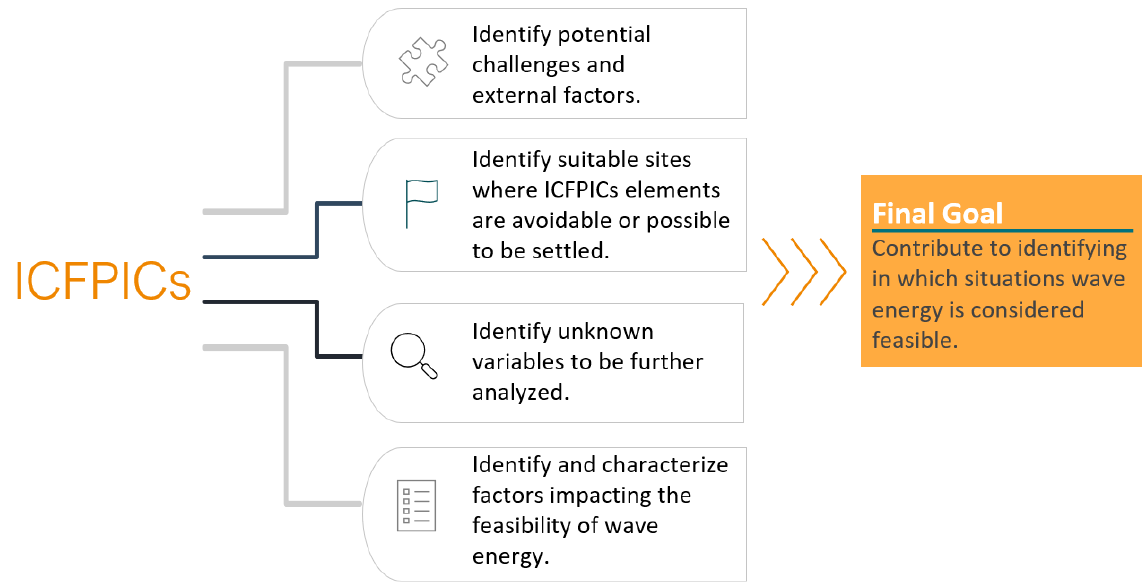
Figure 9. Diagram summarizing the functions of the